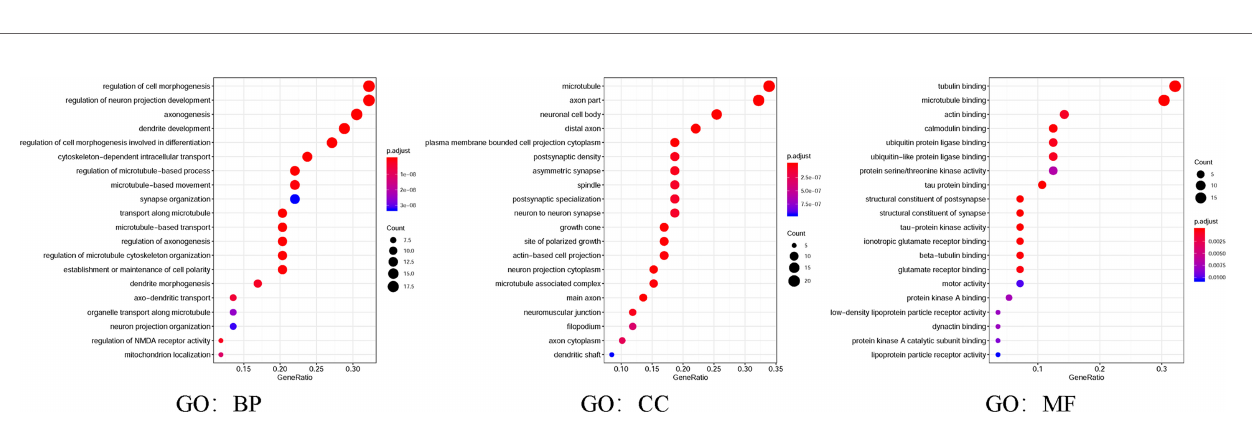
FIGURE 7 | Network of MAP mutations and their 50 frequently altered neighbor genes in NSCLC (STRING). MAP, microtubule-associated protein; NSCLC, non- small cell lung cancer; STRING, Search Tool for the Retrieval of Interacting Genes/Proteins.